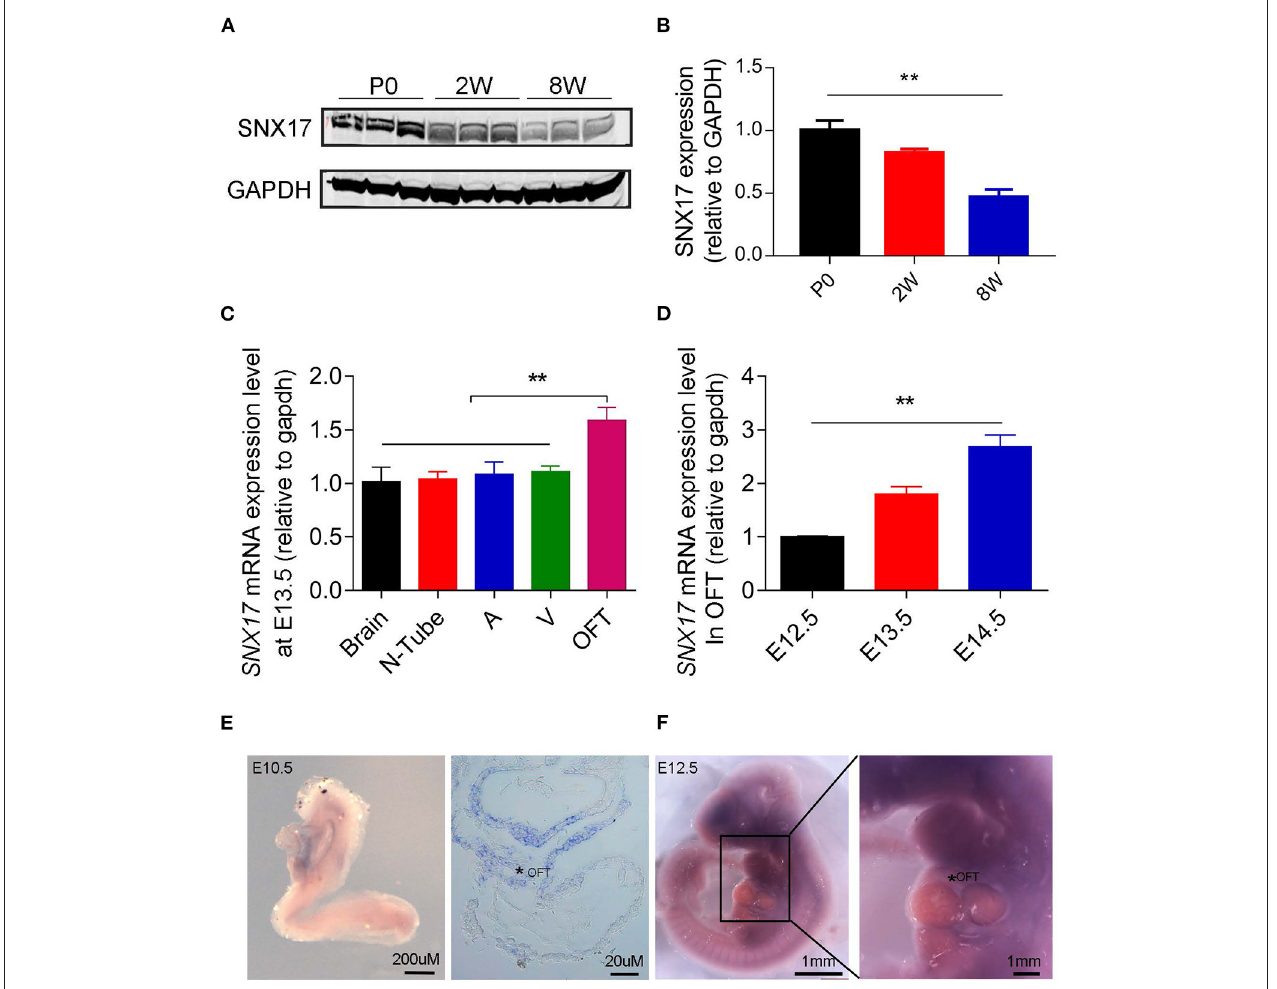
FIGURE 1 | Profiles of SNX17 expression in embryos (A,B) . Western blots showing levels of SNX17 protein in the heart of postnatal rats. n = 3 samples per group ( left , representative blots; right , pooled data). (C) Expression of SNX17 mRNA in multiple tissues at E13.5. n = 5 samples per group. (D) Expression of SNX17 mRNA during the OFT morphogenesis (E12.5–E14.5). n = 5 samples per group. (E) Whole-mount in-situ hybridization for SNX17 in a WT embryo at E10.5. Right panel, a representative microscopy image from a paraffin section (*, OFT). (F) Whole-mount in-situ hybridization for SNX17 in a WT embryo at E12.5. SNX17 , sorting nexin 17; mRNA, messenger RNA; WT, wild-type; N, neural tube; A, atrium; V, ventricle; OFT, outflow tract. ** p <